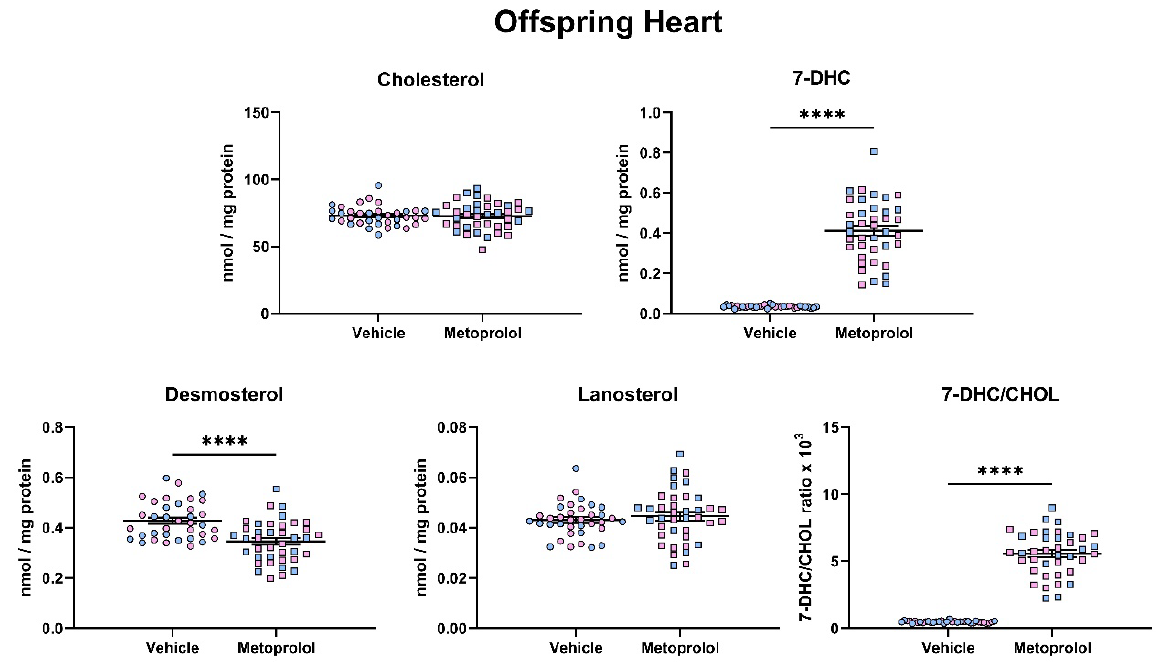
Figure 6. Maternal exposure to metoprolol results in strong elevation of 7-DHC and decreased desmosterol levels in the offspring heart. Pregnant mice were treated with 35 mg/kg MTP from E12 to E19. E19 hearts were analyzed for sterol content by LC-MS/MS. Each symbol represents a sample originating from a single offspring heart. Blue fill = male embryos, pink fill = female embryos. Note the strong change in 7-DHC/CHOL (precursor/product) ratio. Statistical significance: **** p < 0.0001.